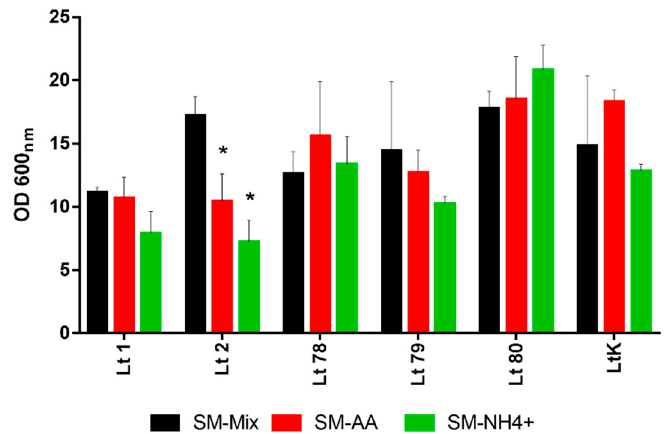
Figure 2. Maximal growth (expressed as OD 600 ) of di ff erent L. thermotolerans strains at the end of fermentation in synthetic must with di ff erent nitrogen sources. Error bars represent standard deviation. * indicates statistically significant di ff erences between media ( p < 0.05).